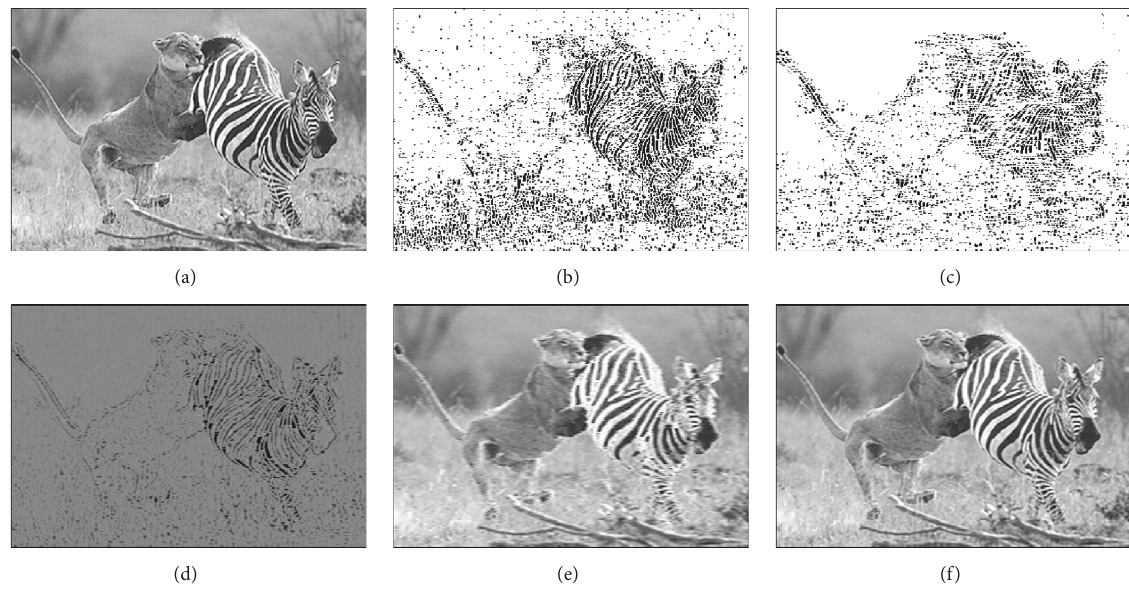
Figure 2: Decomposition (a), component extraction and representation of high frequency component ( 𝜆 ∈ [0,0.1] ) (b), medium frequency component ( 𝜆 ∈ [0.5, 0.7] ) (c), high and medium frequency component ( 𝜆 < 1 ) (d), low frequency component ( 𝜆 = 1 ) (e), and recomposition of all components (f).